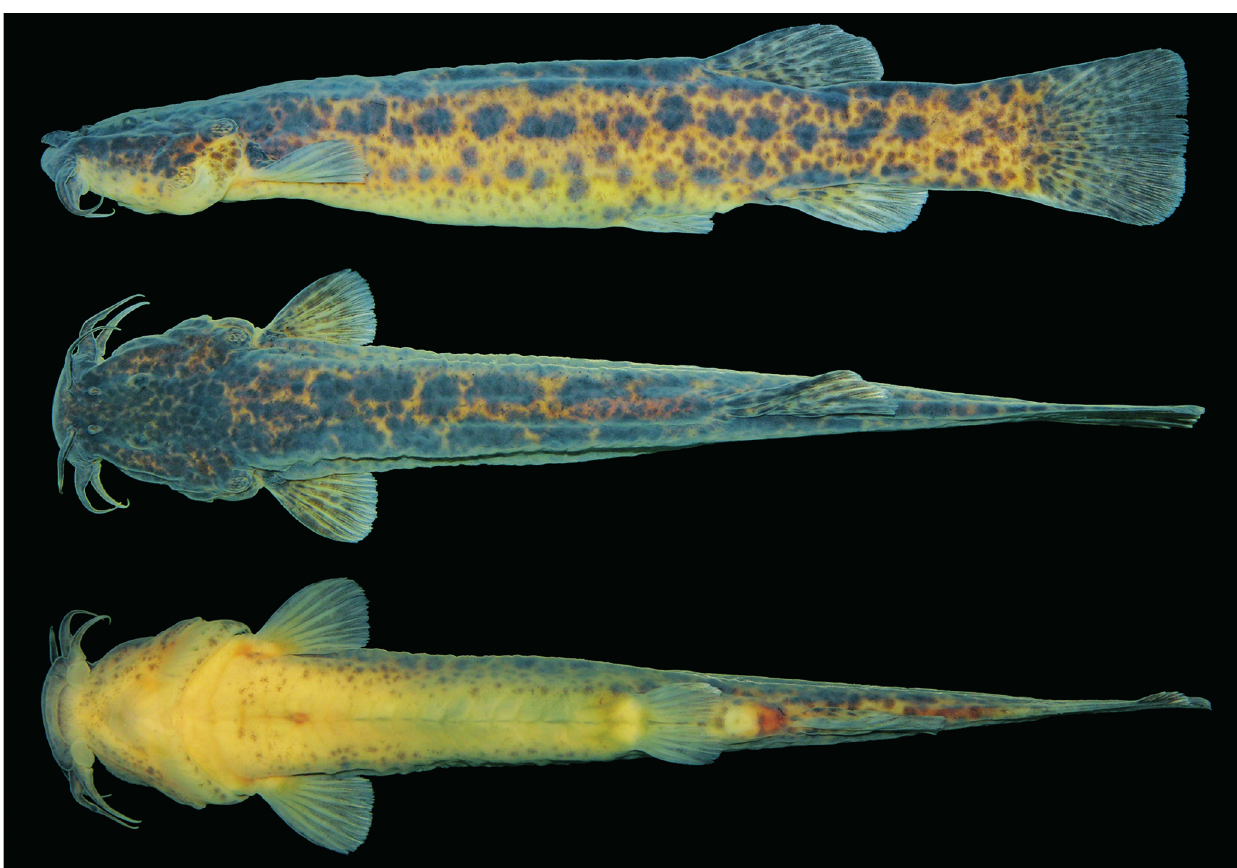
Fig. 1. Trichomycterus balios , holotype, UFRGS 16229, 82.0 mm SL, Brazil, Rio Grande do Sul State, municipality of